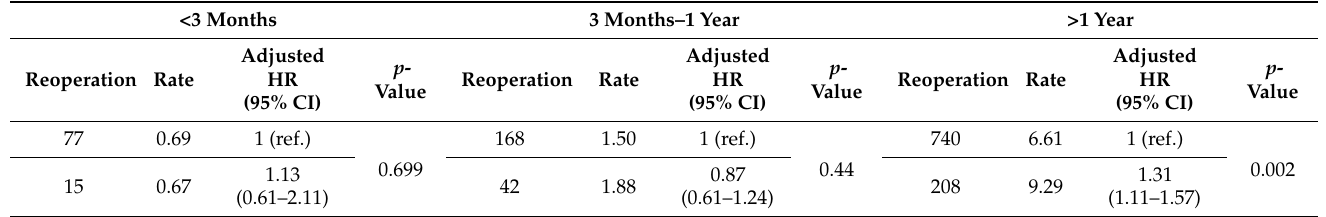
Table 3. Adjusted hazard ratios of reoperation in rheumatoid arthritis (RA) patients comparedwith the control group based on the time between initial operation and